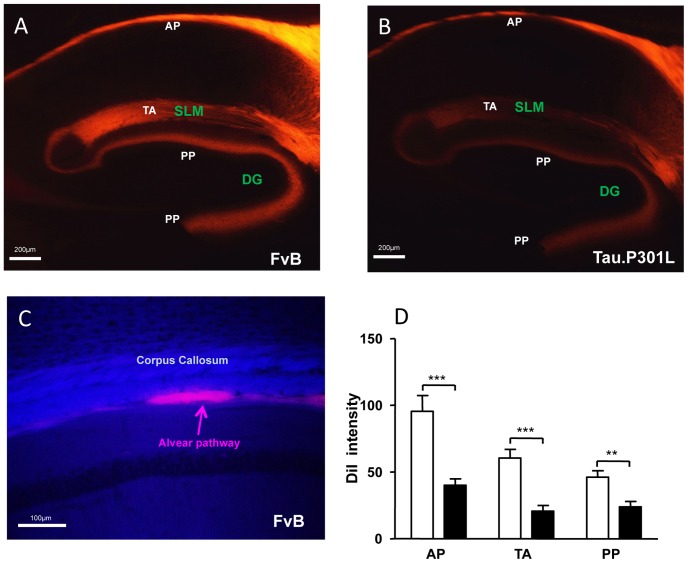
DiI diffusion is reduced in brain of Tau.P301L mice.A,B: images of DiI diffusion patterns from implants in the ERC of brains from FvB (A) and Tau.P301L mice (B) after 14 months incubation. These are representative confocal images but with strongly different contrast and enhancement for the Tau.P301L mice (+3 gain, +4 exposure) which was needed to visualize the pathways. C. Double histological staining of DiI pattern combined with CMC staining for myelin (blue) to locate the alvear pathway (AP) relative to the corpus callosum (CC). D. DiI staining intensity in indicated brain regions of FvB (n = 8) and Tau.P301L mice (n = 8). Statistical analysis: Student’s t-test (unpaired, two-tailed). **p<0.01 and ***p<0.001.